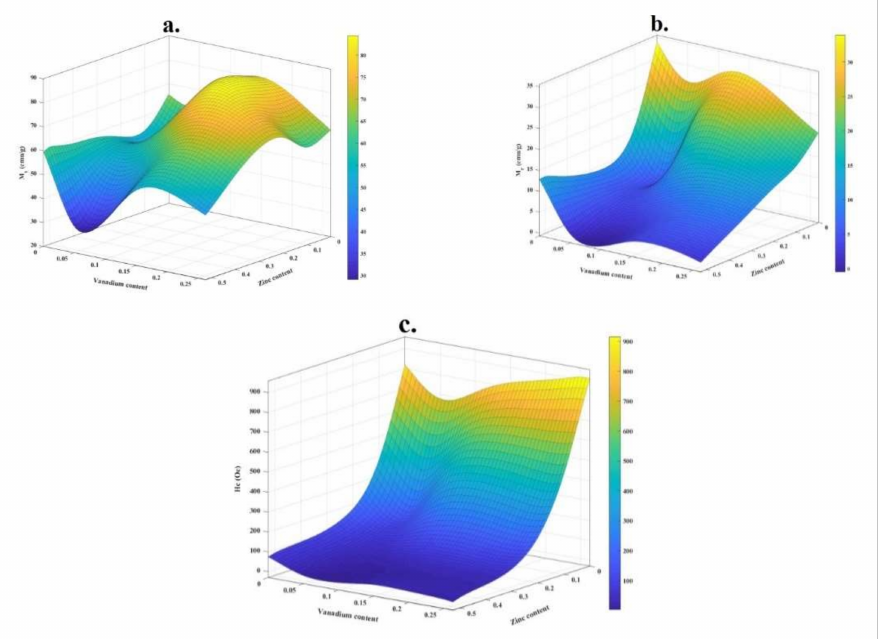
Figure 7. Variation of ( a ) M s , ( b ) M r , and ( c ) H c as a function of Zn and V